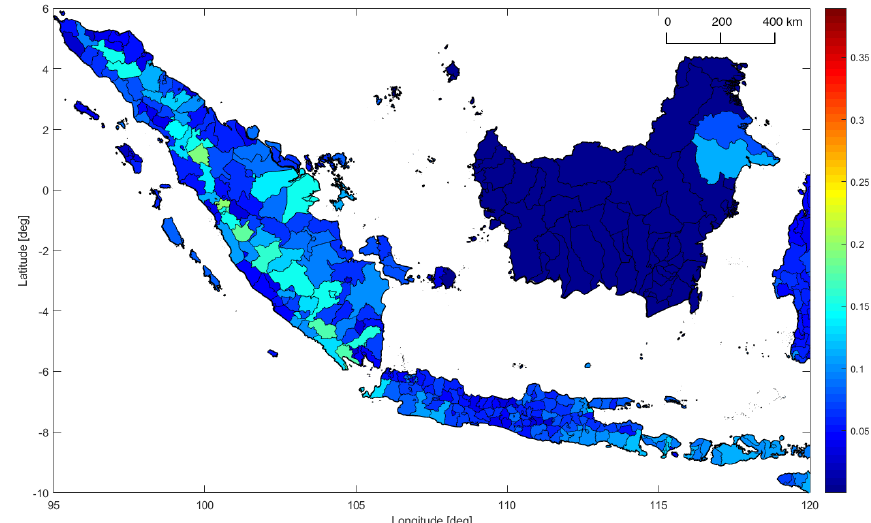
Figure 4. Coefficient of variation (CV) of peak ground acceleration (PGA) with an exceedance probability of 10% in 50 years inside regencies and cities in western Indonesia. Color denotes the CV. At this geographical resolution the CV is lower than for provinces (see Fig. 3), and the influence of individual seismotectonic features, such as the Sumatra fault zone, becomes apparent.